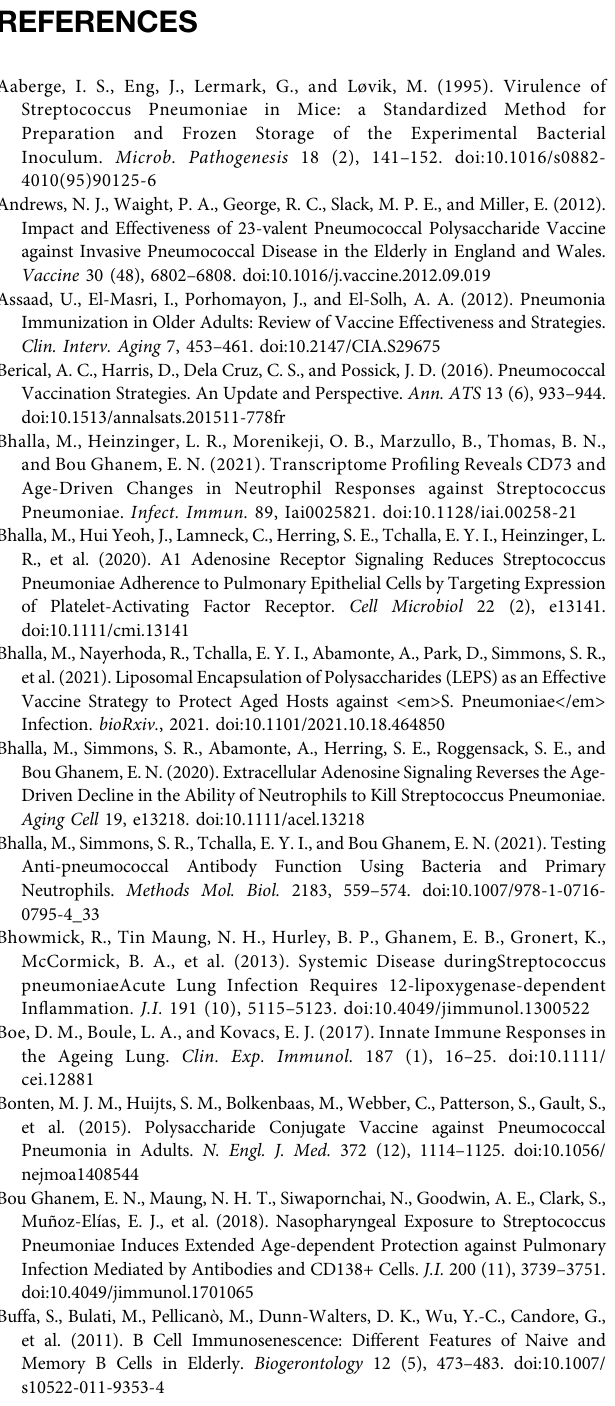
the controls (Sham or Empty LEPS vector) at four weeks post vaccination following the timelineindicatedinFig.1B.Theabilityofseratoneutralizebacterialbindingtopulmonary epithelial cells was determined. S. pneumoniae serotype 4 TIGR4 strain was pre- opsonized for 45 minutes with 10% sera from young (Y) (A) or old (O) (B) mice and usedtoinfectH292cellsfor1hour atanMOIof10.Thenumberofboundbacteriawas determinedbyplatingonbloodagarplates.Thegraphrepresentstheaveragenumberof bound bacteria per experiment for each opsonization